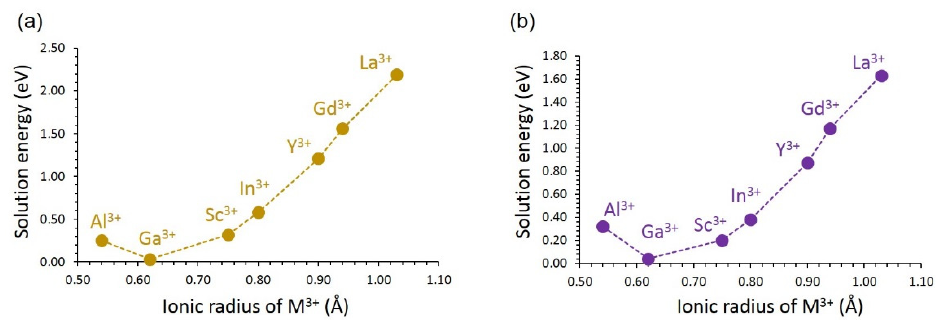
Figure 7. Solution energy of M 2 O 3 with respect to the M 3+ ionic radius in ( a ) LiVSi 2 O 6 and ( b ) NaVSi 2 O 6 ( b ) NaVSi 2 O 6 .